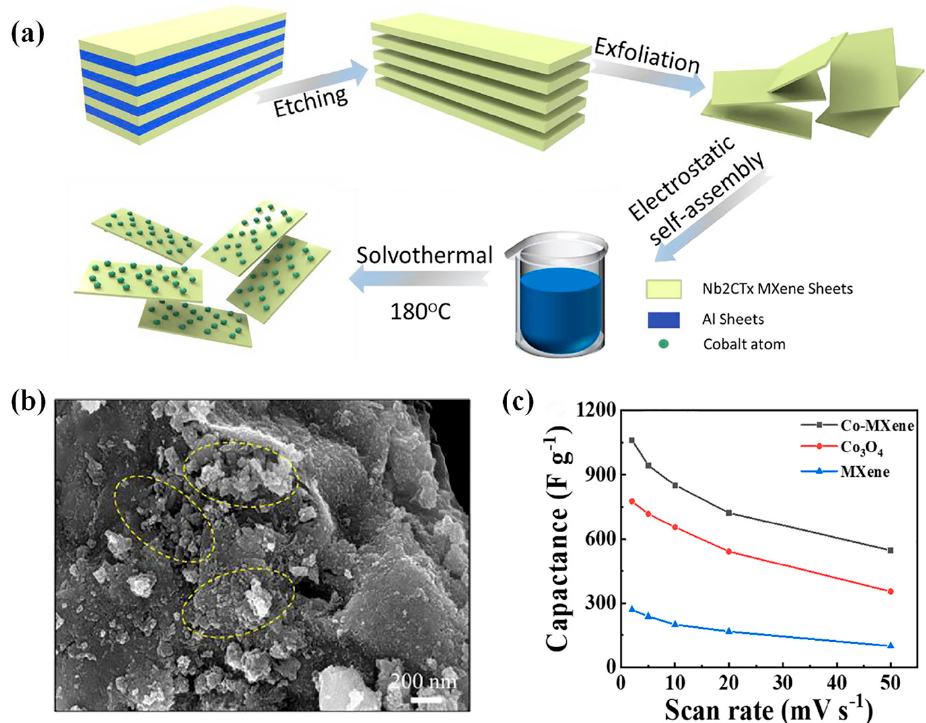
Figure 9. Applications of Nb 2 CT x in supercapacitors. ( a ) Schematic illustration of the preparation procedure of Co-MXene, ( b ) SEM images of the Co-MXene composites, ( c ) Specific capacitance of Co-MXene at di ff erent current densities. [110] Copyright Elsevier, 2022.